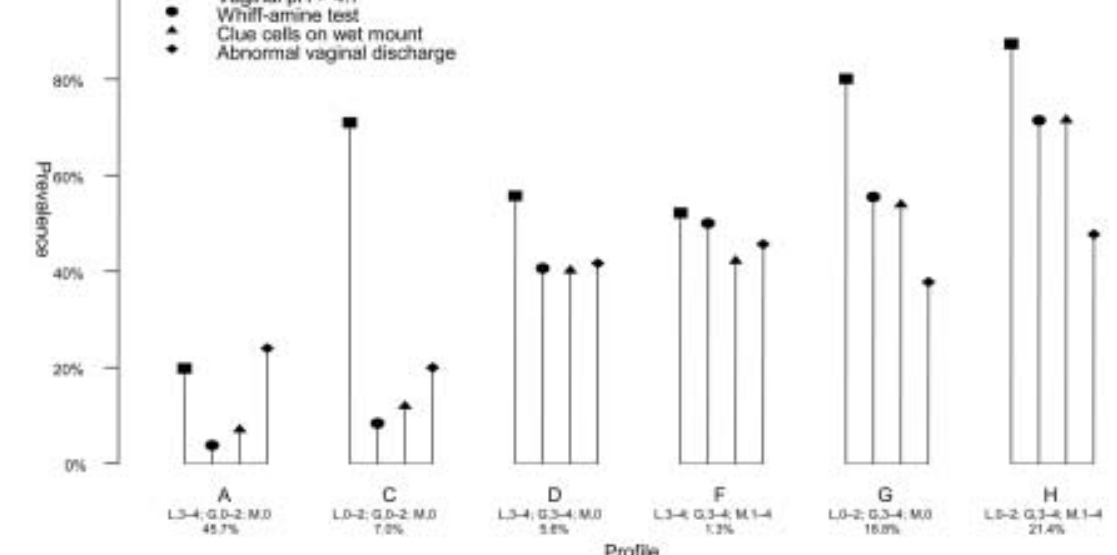
Figure 1 Prevalence of clinical signs by morphotypic